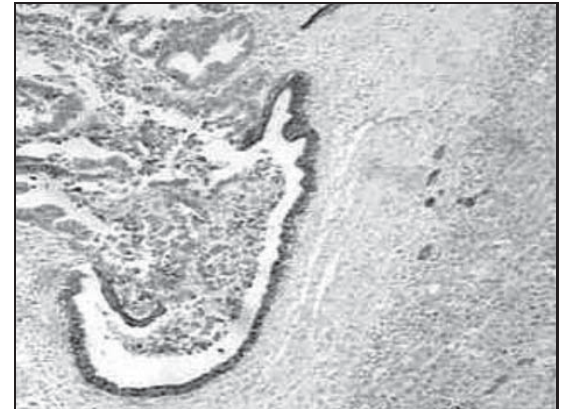
Figura 2 – Fígado com metástase de adenocarcinoma colorretal: positividade para anticorpo CK 20 apenas nas células neoplásicas